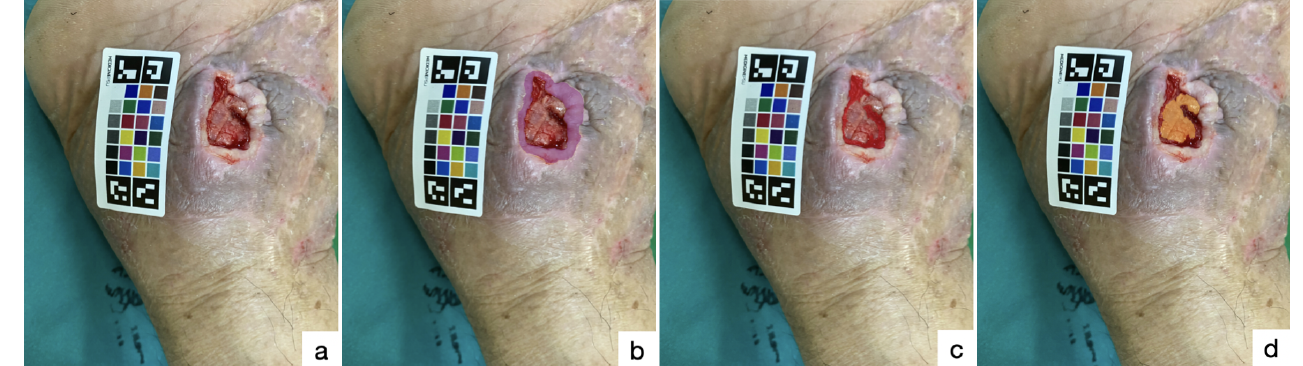
Figure 1. Wound tissue types: ( a ) wound without tissue labeling; ( b ) wound with epithelial tissue labeling in pink; ( c ) wound with granulation tissue labeling in red; and ( d ) wound with necrotic tissue labeling in orange. Our calibration chart was placed near the wound for color and measurement